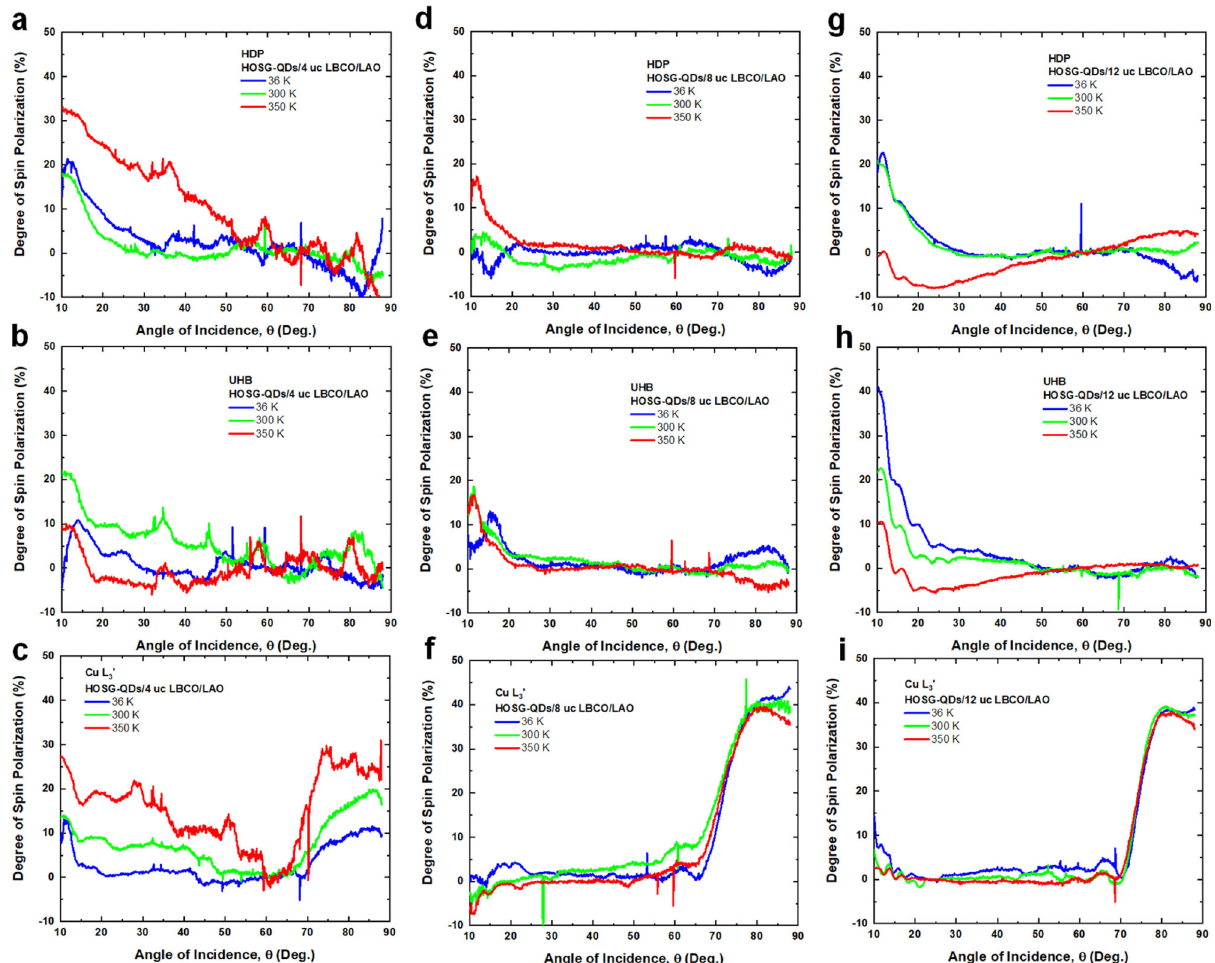
Fig. 5 Degree of spin polarization as a function of temperature. Degree of spin-polarization at T = 36 K, 300 K, and 350 K: for HOSG-QDs/4uc LBCO/ LAO at a HDP, b UHB, and c Cu L 3 ’ ; for HOSG-QDs/8uc LBCO/LAO at d HDP, e UHB, and f Cu L 3 ’ ; and for HOSG-QDs/12uc LBCO/LAO at g HDP, h UHB, and i Cu L 3 ’